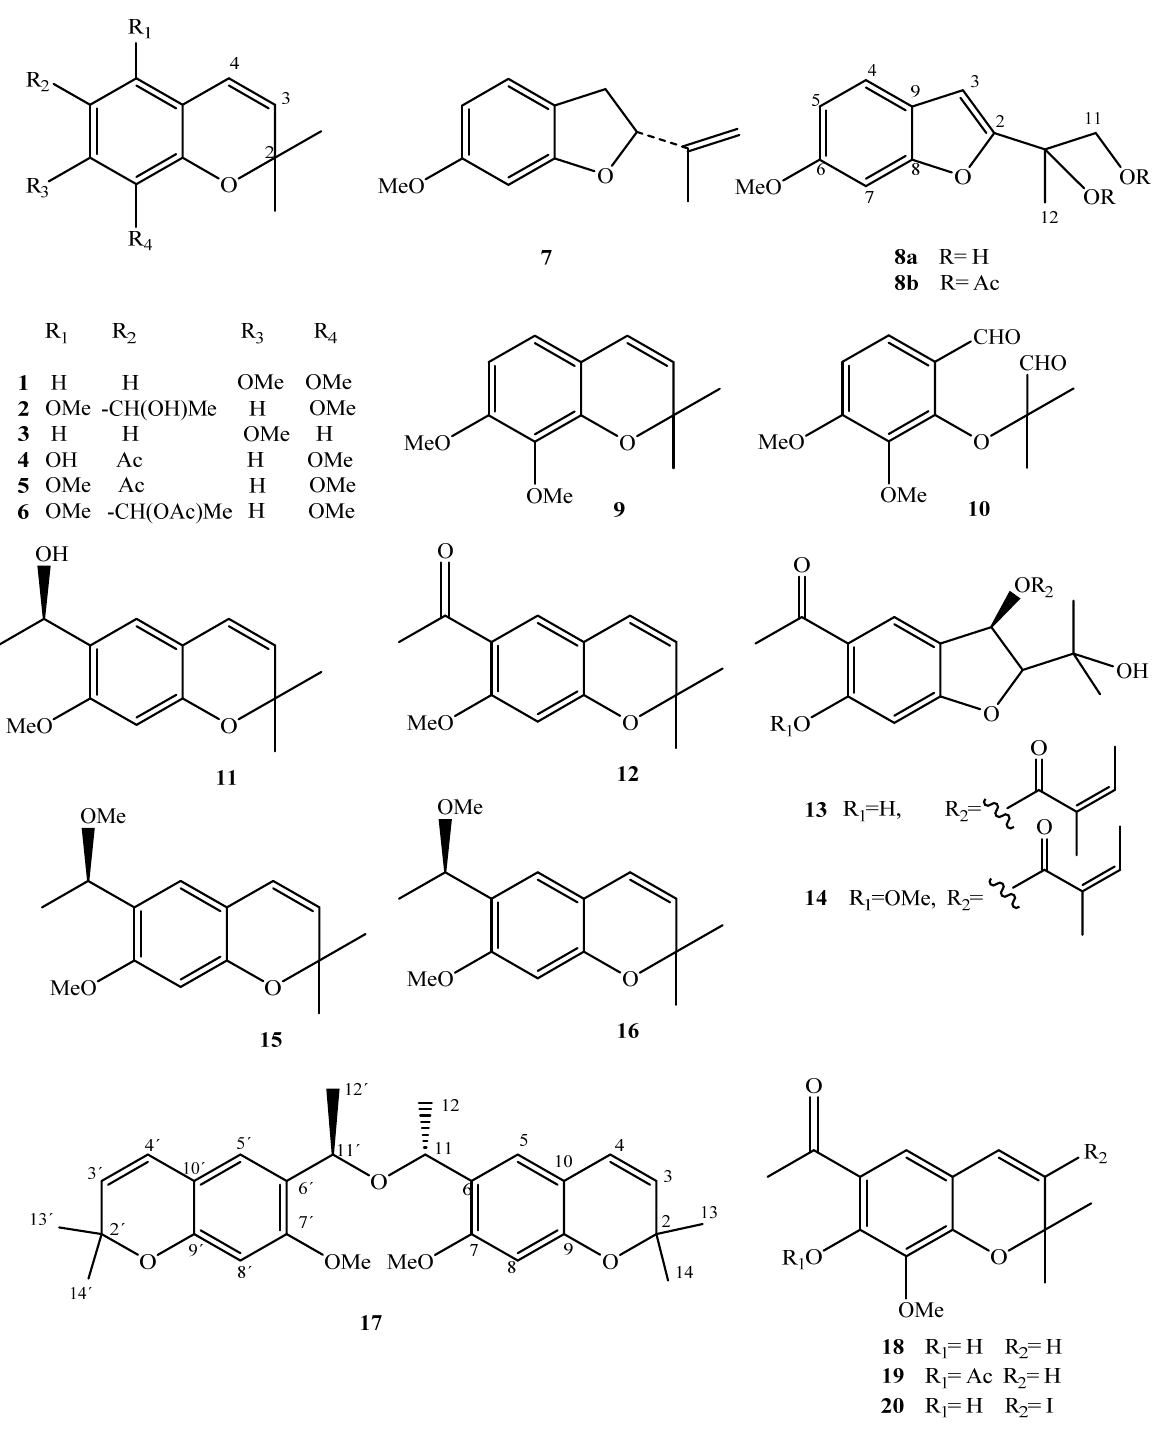
Figure 3. Chemical structure of benzochromenes and benzofurans isolated from A. pichinchensis . In some Asteraceae species, such as Arnica montana and Arnica chamissonis , im- portant phenolic compounds have been found, e.g., chlorogenic acid ( 29 ), 7- O -( β -D- glucopyranosyl)-gossypetin ( 30 ), and 7- O -( β -D-glucopyranosyl)-galactin ( 31 ) (Figure 4 and Table 1) [25,26]. Traditionally, these plant species have been used to treat wounds [56]. A. pichinchensis it is a closely related species, of which the compounds 29 , 30 , and 31 were also